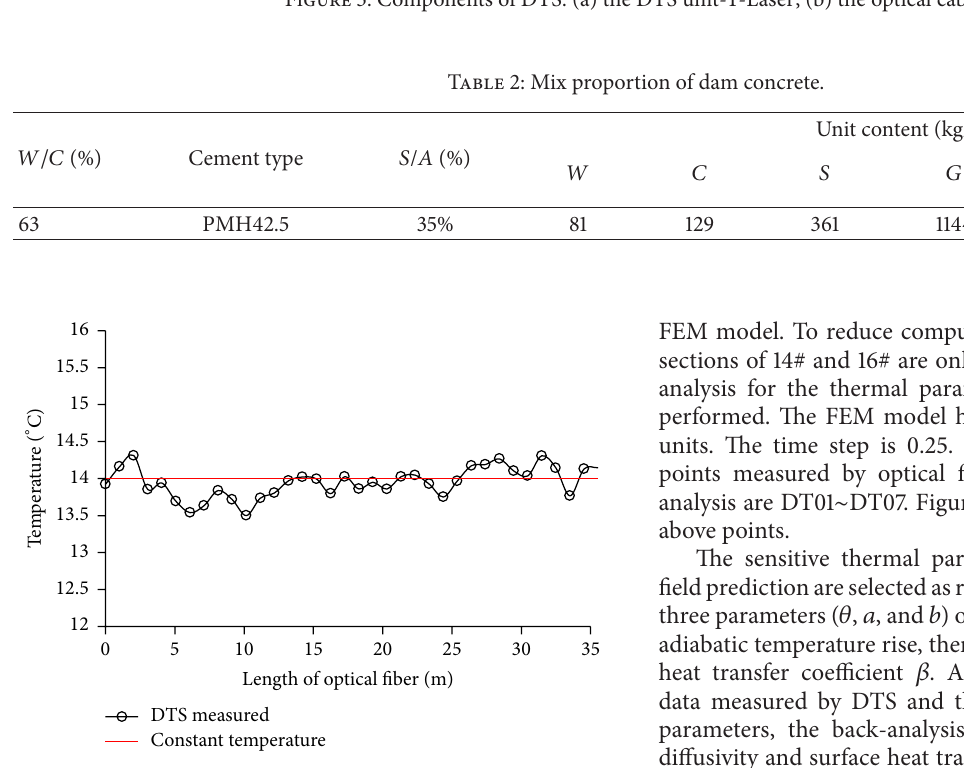
Figure 3: Components of DTS: (a) the DTS unit-T-Laser; (b) the optical cable.